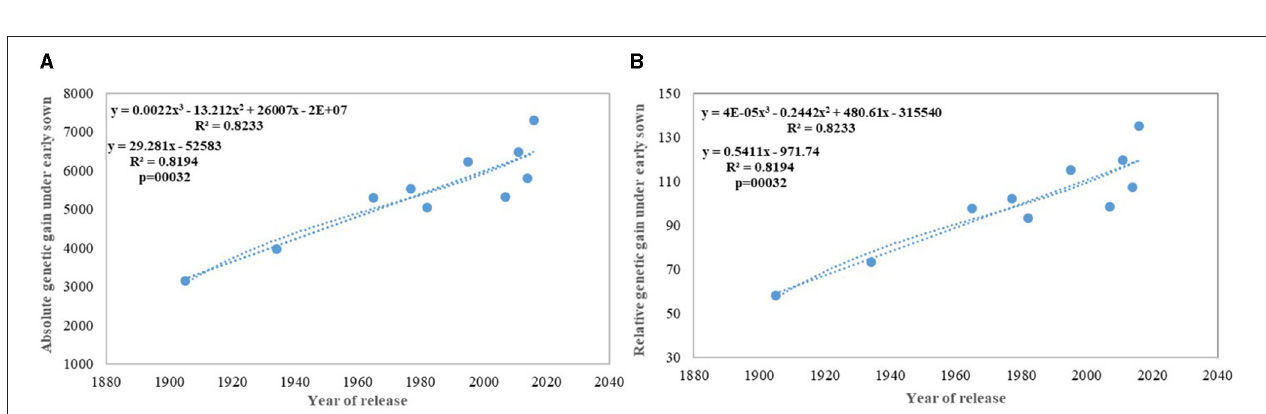
FIGURE 6 | Regression equation between phenological and yield component traits against the year of release under early sown conditions. (A) Days to maturity, (B) Grains per spike, (C) Thousand grain weight (g), (D) Biomass under early sown (Kg ha − 1 ).